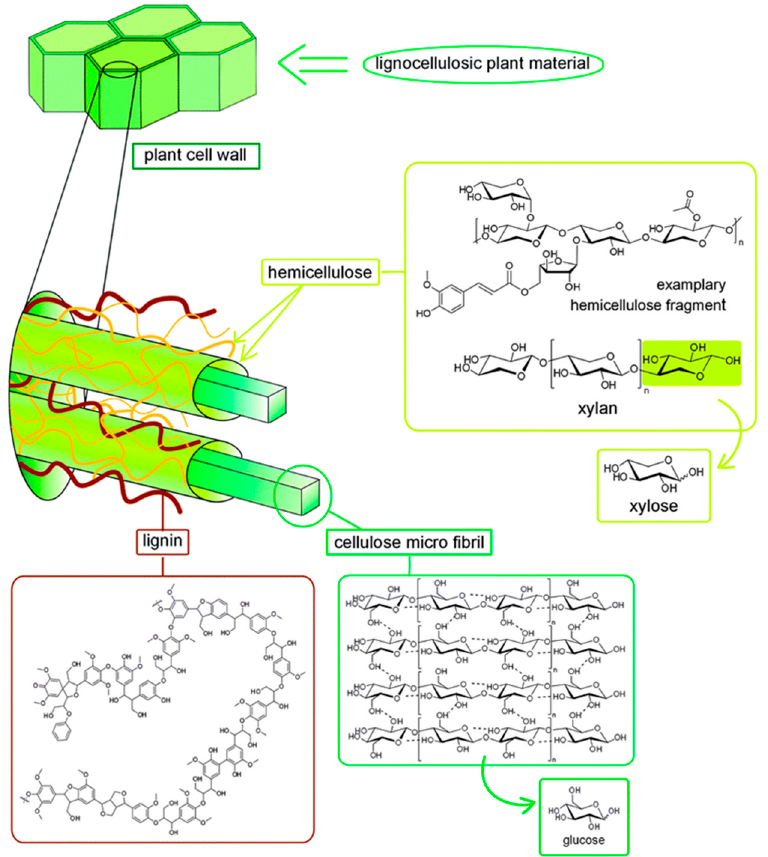
Figure 3. Composition of lignocellulosic biomass. Reproduced with permission from ref. [80]. Copyright 2013 Royal Society of Chemistry.